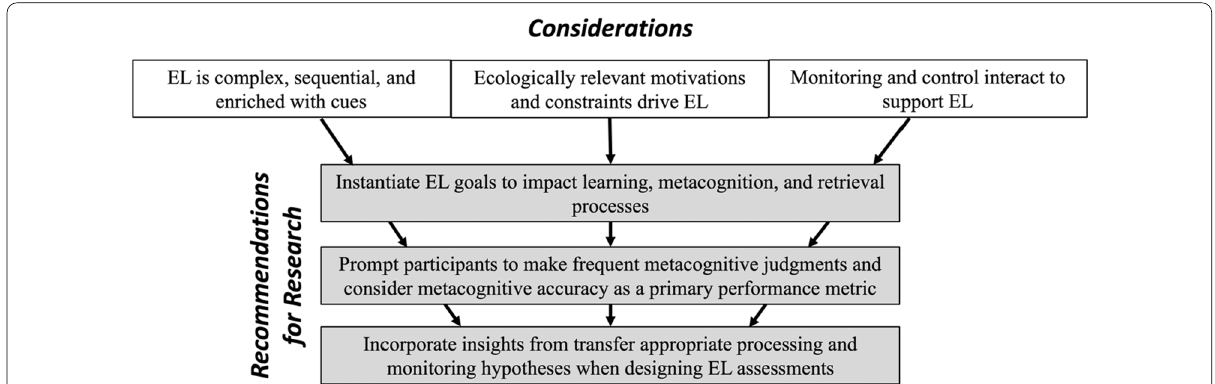
Fig. 2 Summary of considerations and recommendations for investigating metacognition’s role in